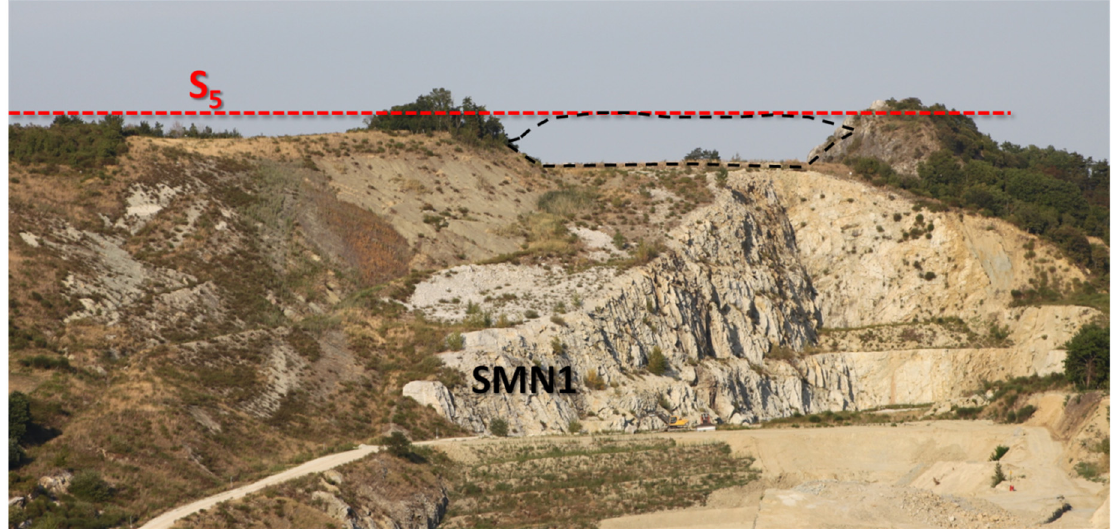
Figure 4. Example of sub-flat (S 5 ; red dashed line) and discordant erosion surface on the vertical calcarenites of the San Marino formation—Basic member (middle Eocene—upper Miocene). The outcrop is located at an abandoned quarry in Mt. Ceti (black dotted line indicates the missing volume of the original surface, quarried for construction use).